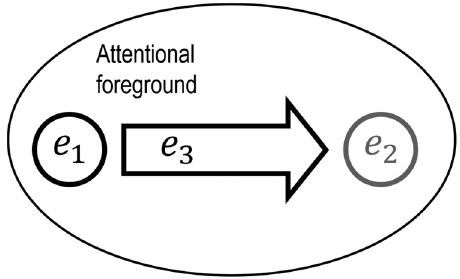
Figure 3: If e 3 connects e 1 and e 2 , does this mean that both e 1 and e 2 have to be in the foreground? If so, it cannot connect items in the foreground with items in the background.